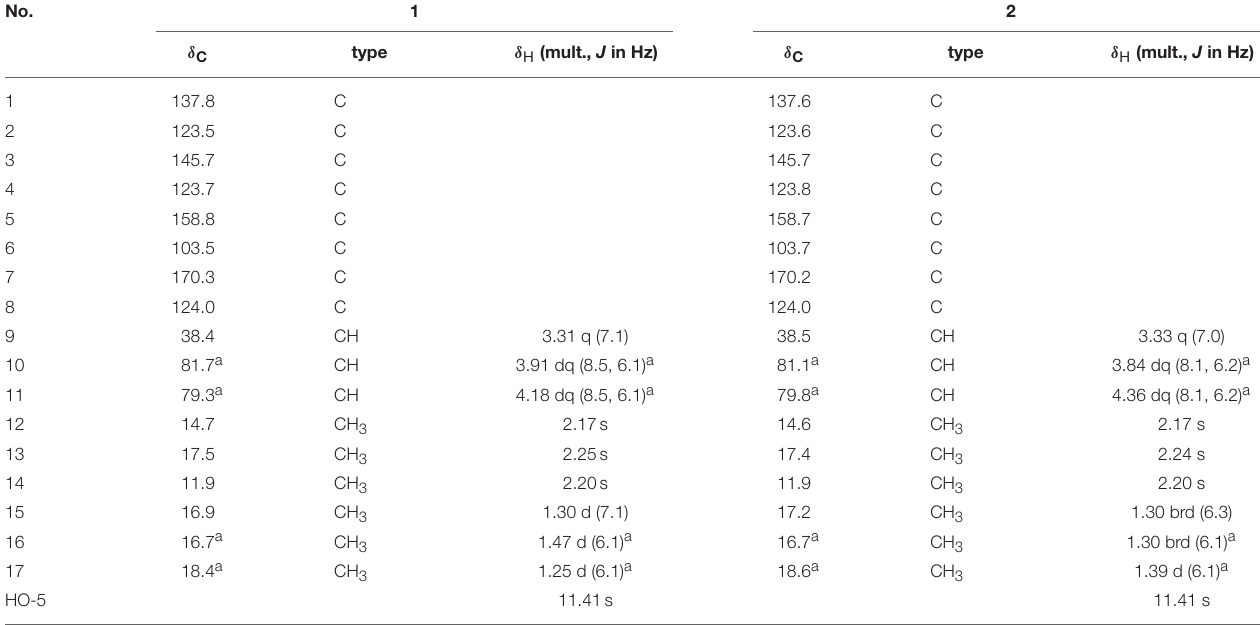
TABLE 1 | 1 H and 13 C NMR Spectroscopic Data for 1 and 2 (in CDCl 3 ). No.